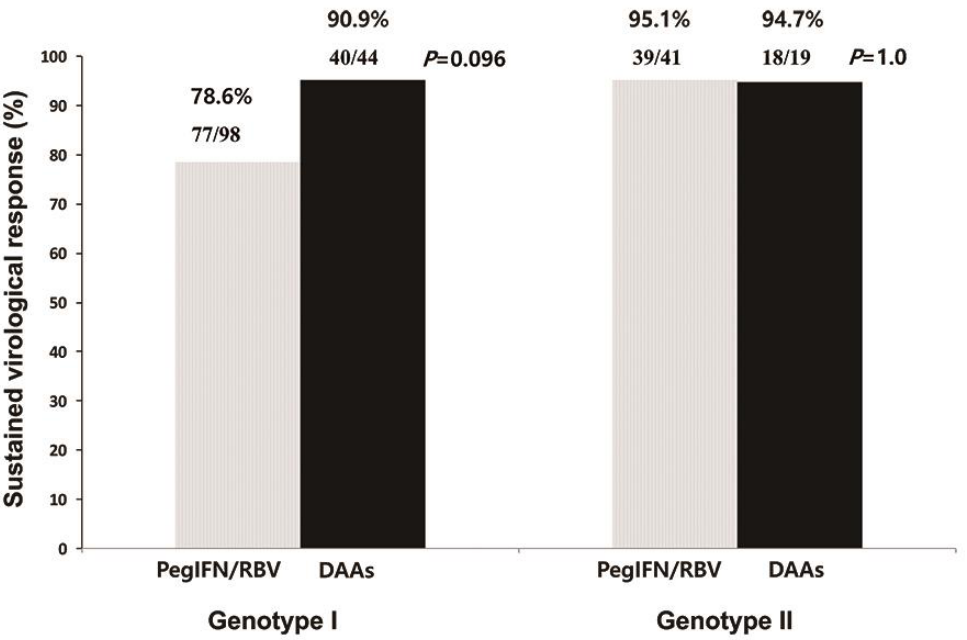
Figure 2. Treatment responses to pegylated interferon plus ribavirin and direct-acting antivirals. PegIFN/RBV, pegylated interferon plus ribavirin; DAAs, direct-acting